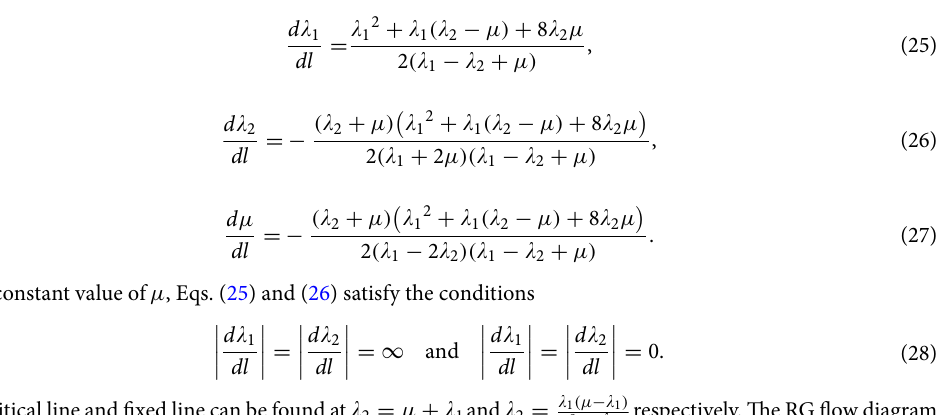
π in (cid:31) 1 - (cid:31) 2 plane for ( a ) µ =